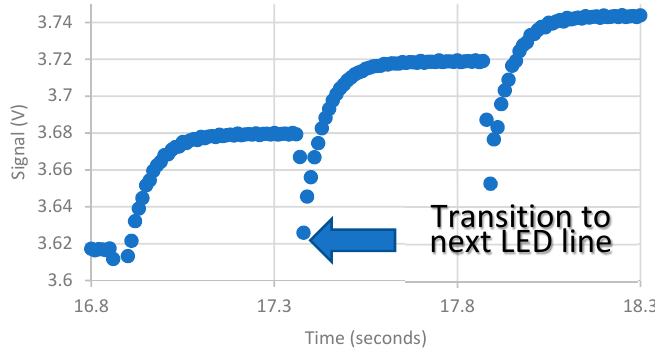
Figure 13. Signal at transition to next LED line.